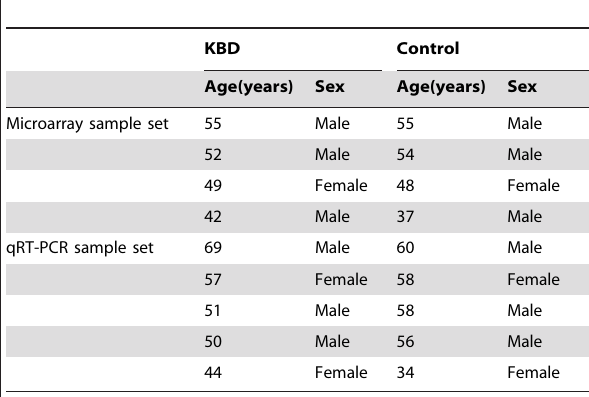
Table 4. KBD-control sample pairs used for microarray and qRT-PCR.